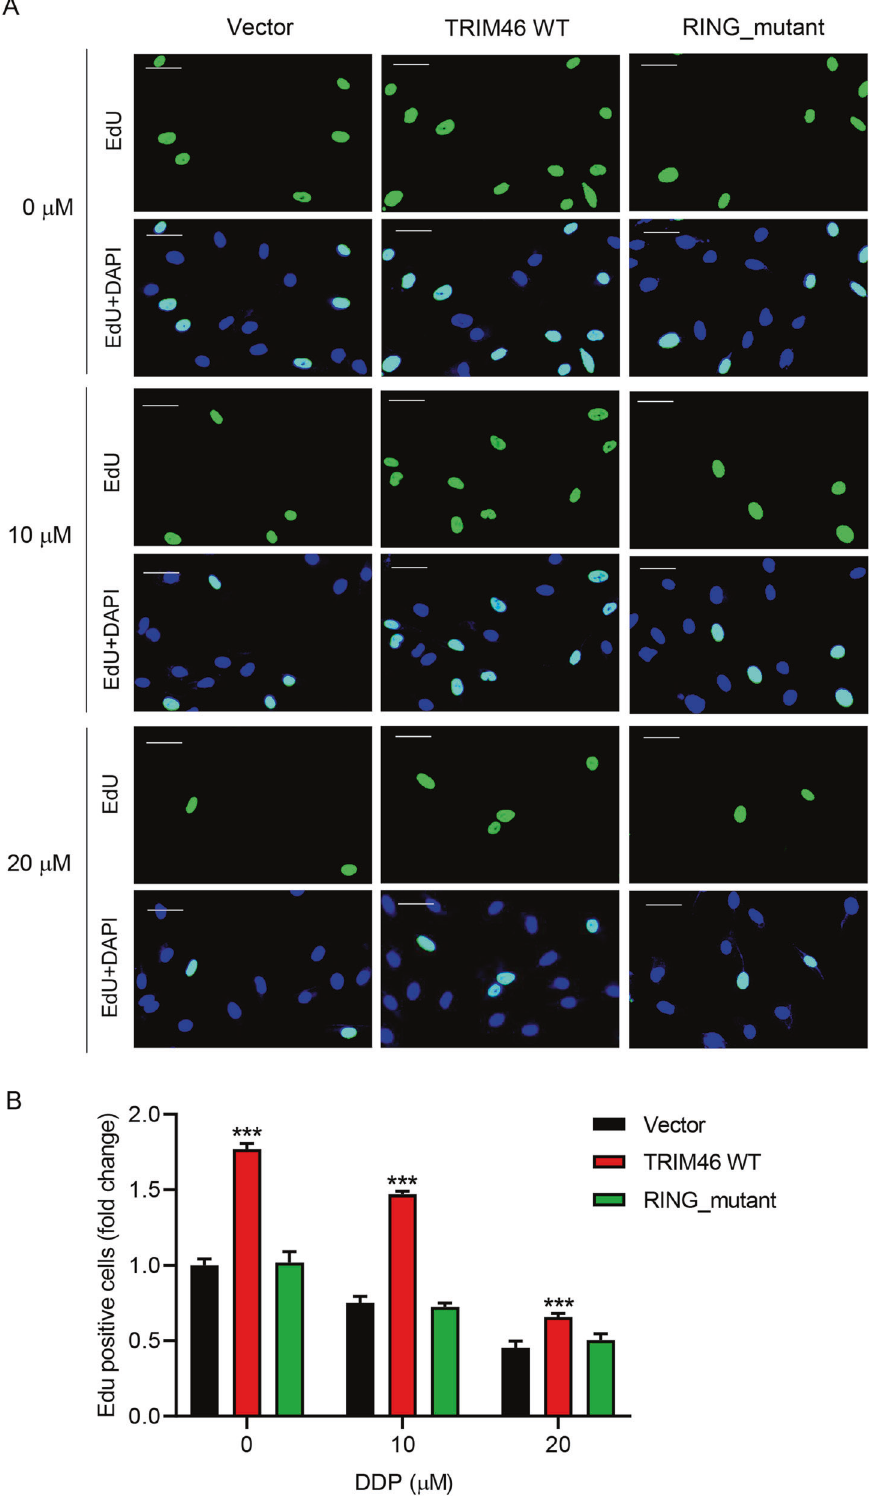
Fig. 3 TRIM46 overexpression increased cell proliferation and DDP resistance of LUAD cells. A549 cells were transfected with WT-TRIM46, RING-mutant TRIM46, or Vector and treated by DDP (0, 10, or 20 μ M). A A549 cell proliferation measured by EdU staining (scale bar: 50 μ m). B Statistical analysis of EdU positive A549 cells. Results were presented as the mean ± standard error ( n = 3). Independent experiments were repeated three times. *** P < 0.001 vs Vector.